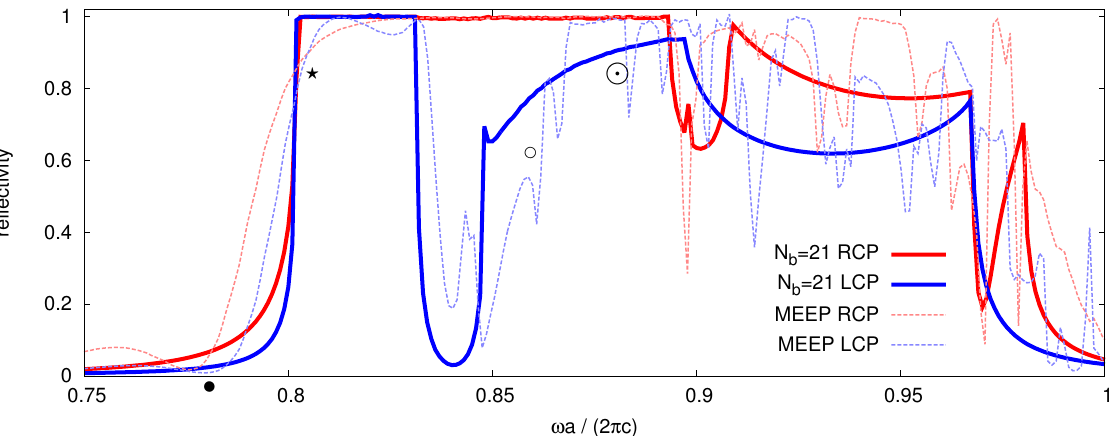
Figure 12. Reflectance spectrum for a plane wave at normal incidence onto a r 100 s inclined single gyroid photonic crystal (PhC), for left- and right-circularly polarized light. The parameters are the same as in Figure 10. Spectra with right circularly polarized (RCP) incident light are shown in red and with left circularly polarized (LCP) light in blue. The solid lines represent a calculation with N “ 2517 plane waves and N “ 21 Bragg orders, b i.e. , the 2 N “ 42 Bloch modes with the smallest absolute wave number and propagating b (decaying) away from the surface have been used. A computation with a smaller resolution N “ 1503 and N “ 13 shows no difference, except for the small peak at ωa {p 2 πc q “ 0 . 9 , b which is not resolved. The dashed lines in less saturated colors correspond to an average over a few slabs with varying thickness around 6 a , simulated with MEEP (data from Figure 5A in